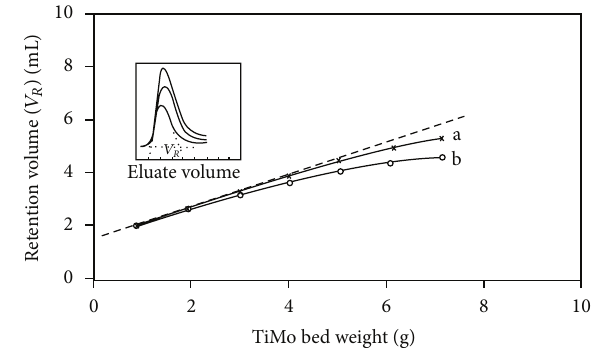
Figure 17: Retention volume 𝑉 𝑅 versus TiMo-column-bed weight (TiMo particle size 100–200 mesh; column size 10 mm i.d.). a: acetone as eluent; b: 0.9% NaCl solution as eluent [59, 106].